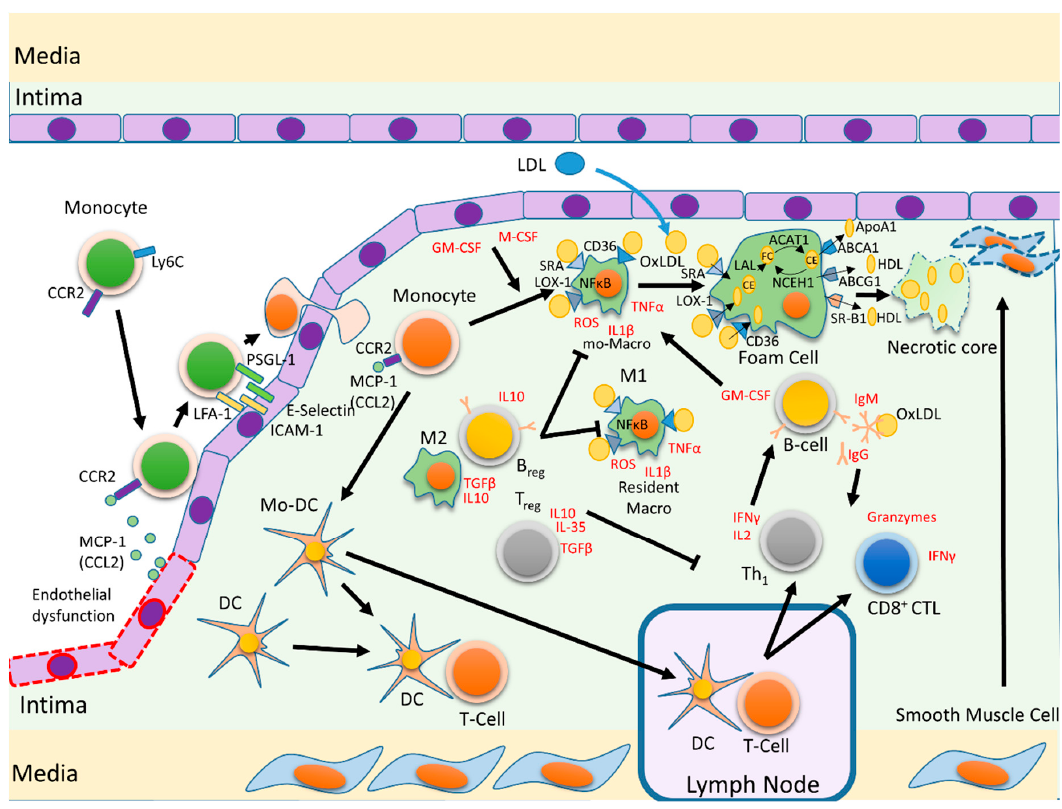
Figure 2. Pathogenesis of atherosclerosis. Atherosclerosis is a chronic inflammatory disease characterized by endothelial dysfunction and accumulation of low-density lipoproteins (LDLs), immune cells, and necrotic debris in the subendothelial space. Endothelial activation triggers the expression of leukocyte adhesion molecules, such as E and P-selectins, the glycoproteins ICAM-1 and VCAM-1, and the chemokine MCP-1, which signals via CCR2 to stimulate migration and infiltration of inflammatory monocytes. LDL deposition promotes the release of M-CSF and GM-CSF, which facilitates the maturation of infiltrating monocytes into macrophages or dendritic cells. LDLs give rise to modified-LDLs (especially oxLDL) that are recognized by macrophage scavenger receptors, such as CD36, LOX-1, and SR-A. These scavenger receptors activate NF κ B signaling in macrophages, enhancing the release of proinflammatory cytokines, such as IL1 β and TNF α , and leading to the generation of foam cells. Foam cells uptake ox-LDL, and LAL converts cholesterol esters (CE) into free cholesterol (FC) and free fatty acids. FC can be converted into CE by ACAT1 and ACAT2. NCEH1 transforms CE into FC. FC can be transported outside the foam cell by ABCA1, ABCG1, and SR-B1. APCs, such as DCs, process intraplaque oxLDLs and stimulate the adaptive immune response by presenting oxLDL-derived antigens in atheromatous plaques and in secondary lymphoid organs. M1 macrophages, Th1